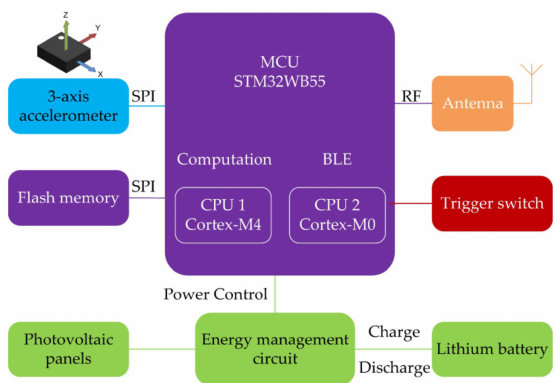
Figure 2. Microsystem block